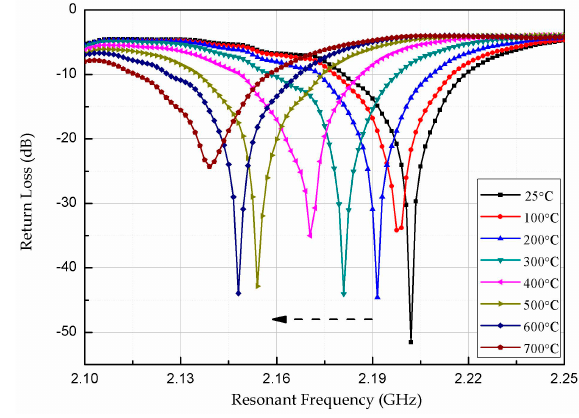
Figure 10. Return loss versus resonant frequency at various temperatures.